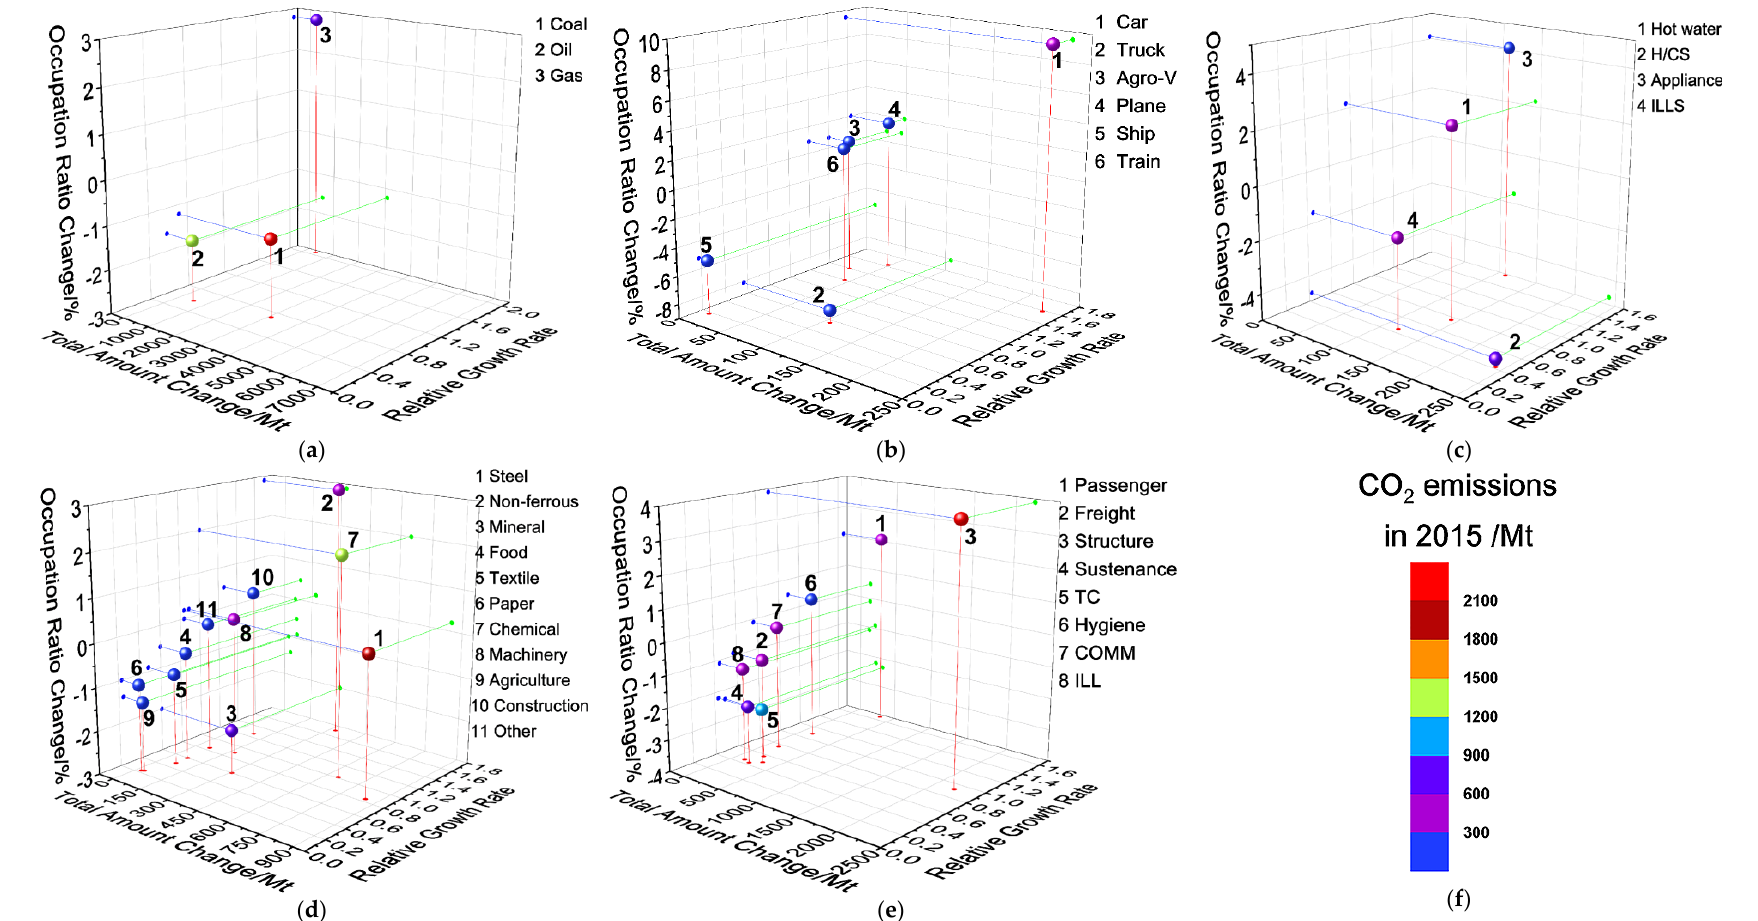
Figure 5. The TRO index decomposition of energy-related CO 2 emissions in 5 sections including: ( a ) Energy sources; ( b ) Vehicle; ( c ) Building; ( d ) Factory; ( e ) Final services. ( f ) The color of the dots in the diagram represents the total CO 2 emissions of relevant sectors in 2015.